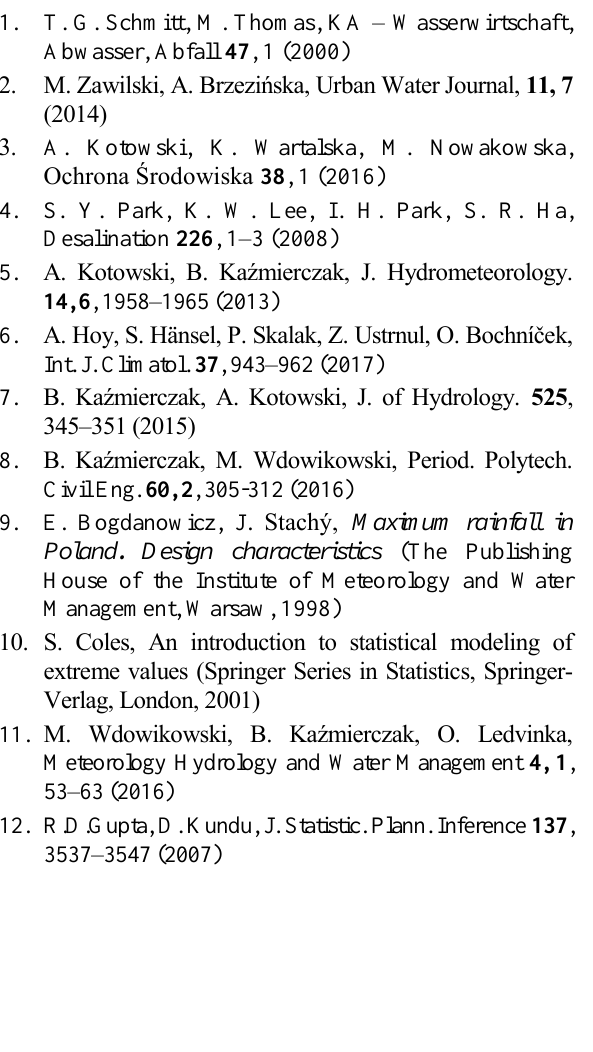
Table 5. The percentage change in the rainfall amount.